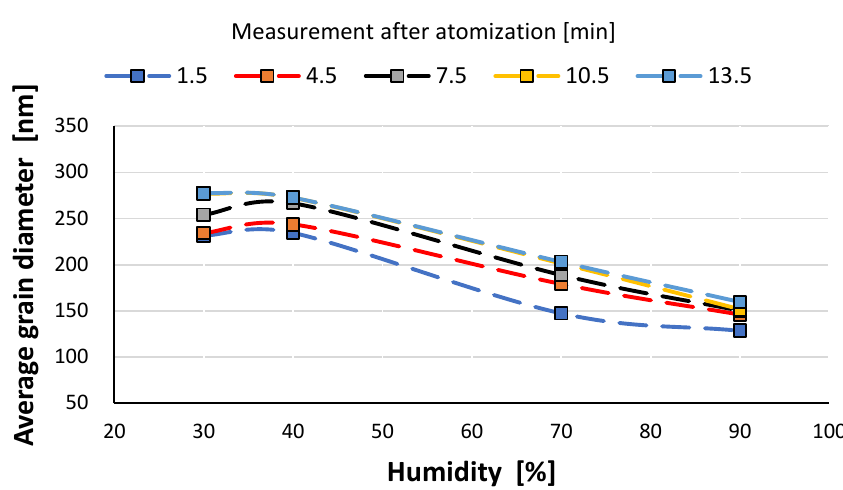
Figure 11. Change in nanoparticle abundance of the most common fraction.